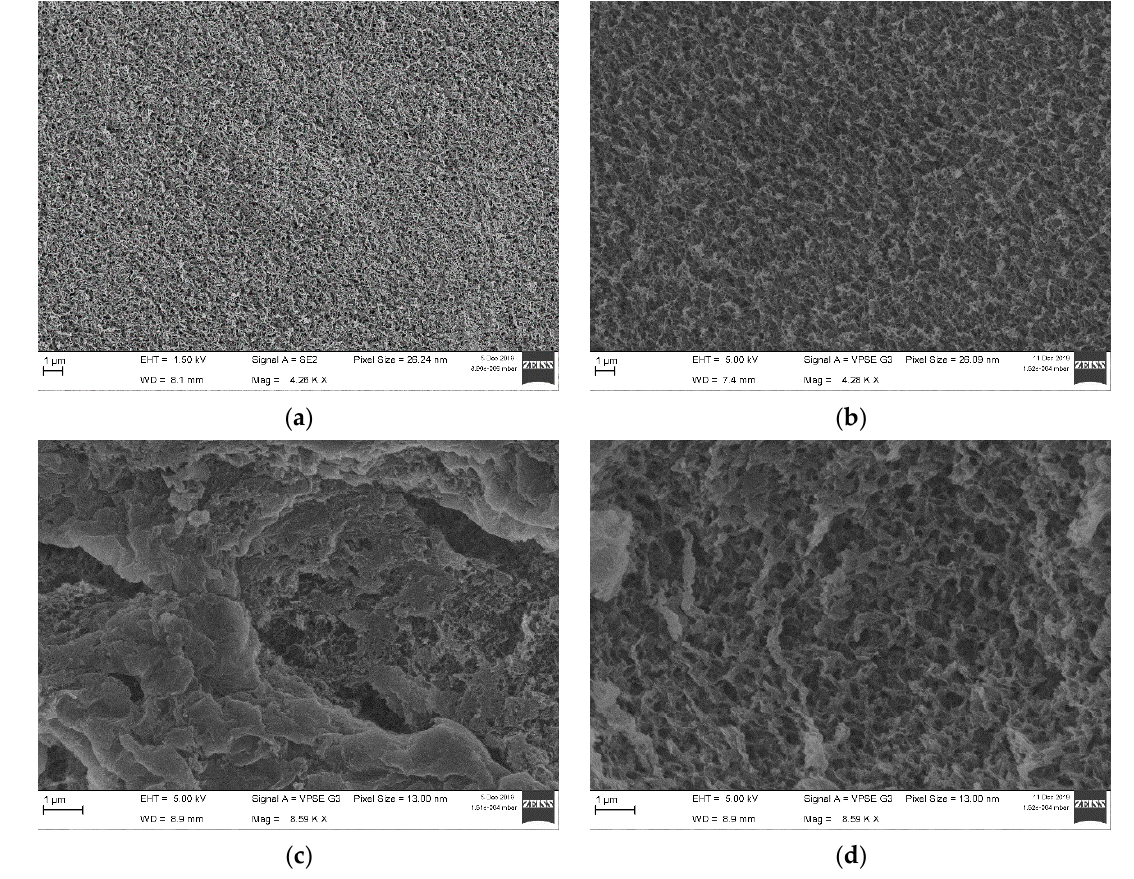
Figure 1. FE-SEM images of surfaces ( a , b ) and cross-sections ( c , d ) of Cel0 (left) and Cel30 (right) beads. CMC addition increases pore sizes on the surface and inner regions of the beads.